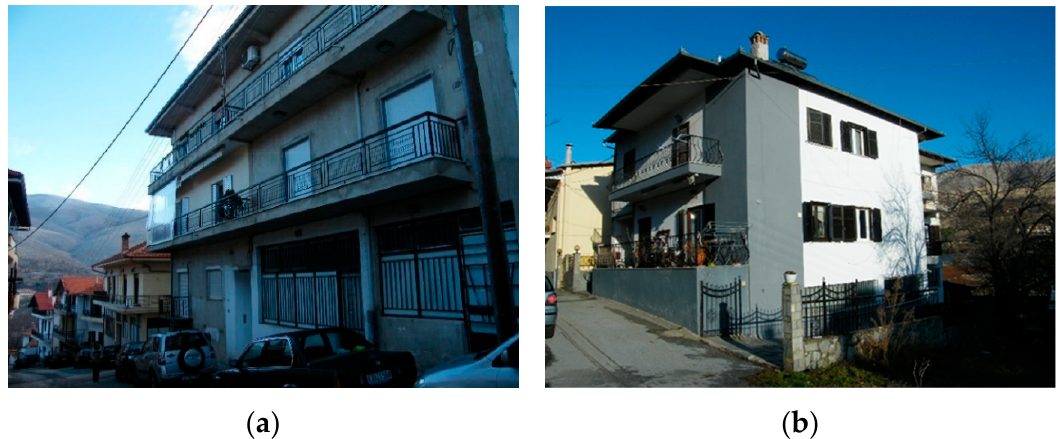
Figure 5. New road.